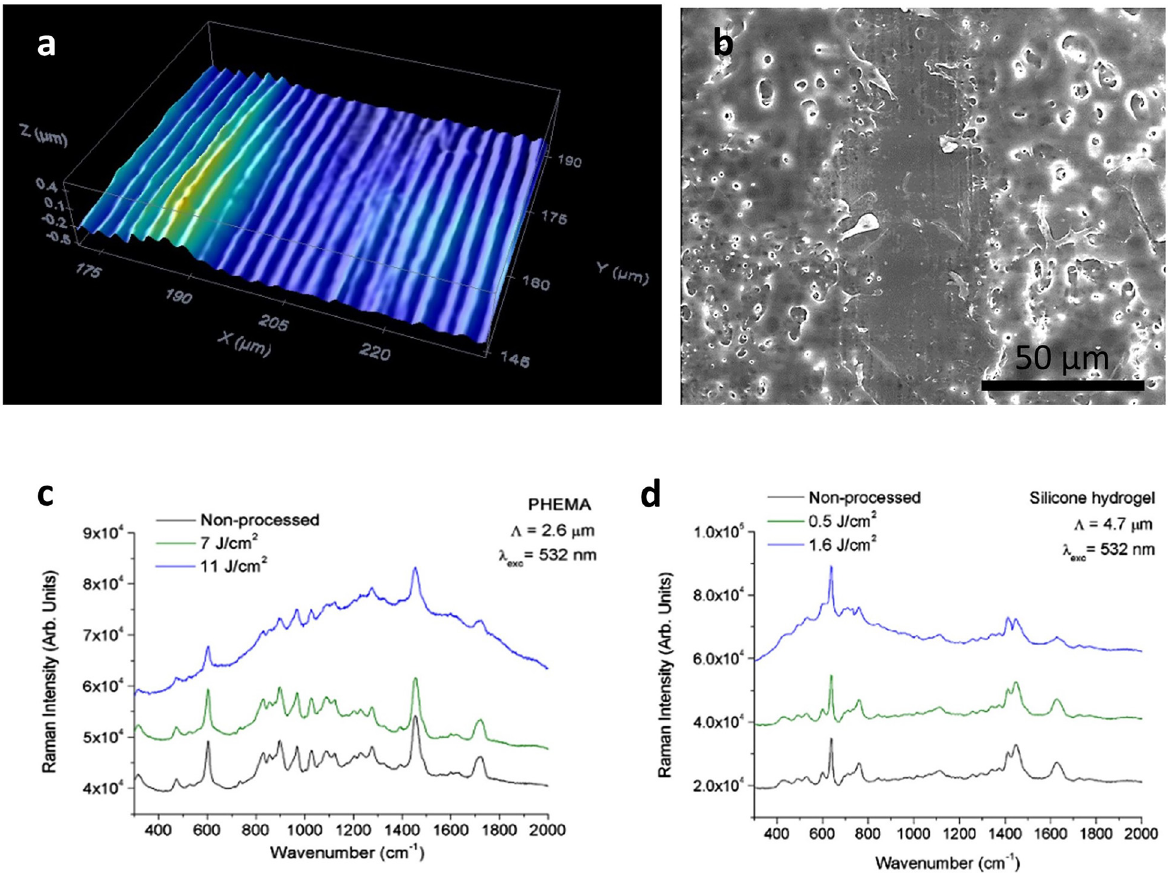
Figure 12: (a) Confocal image of a PHEMA sample structured (2.6 µm, 1 pulse, 7 J cm − 2 ), (b) SEM micrograph PHEMA samples structured (2.6 µm, 1 pulse, 11 J cm − 2 ), µ -Raman spectra of Micro-Raman spectra of (c) PHEMA sample in non-processed areas (black line) and in the DLIP structured regions with a spatial period of 2.6 μ m at 7 J cm − 2 (green line) and 11 J cm − 2 (blue line) laser fl uence (d) silicon hydrogel in non- processedareas(blackline)andintheDLIPstructuredregionswithaspatialperiodof4.7 μ mat0.5Jcm − 2 (greenline)and1.6Jcm − 2 (blueline) laser fl uence. Reproduced from ref. [123] with permission from Japan Laser Processing